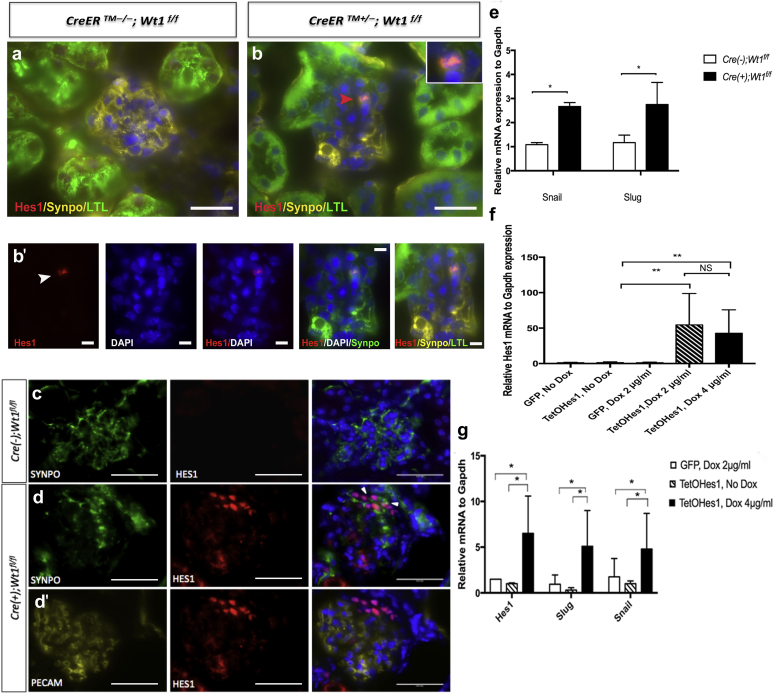
Hairy enhancer of split 1 (HES1) expression coincides with onset of glomerulosclerosis in CAGG-CreERTM+/−;Wt1f/ftransgenic mice. (a,b,b′) Shown are representative images of glomeruli following double immunofluorescence labeling of day (D) 5 postinduction (PI) mouse kidney sections with anti-HES1, anti-Synaptopodin, and Lotus tetragonolobus lectin (LTL) of CAGG-CreERTM−/−;Wt1f/f (mutant) and CAGG-CreERTM+/−;Wt1f/f (control) transgenic mice following multichannel labeling with Alexa Fluor 488–conjugated secondary antibody (LTL, demarcates tubules), Alexa Fluor 594–conjugated secondary antibody (Hes1), and Alexa Fluor 647–conjugated secondary (Synaptopodin, demarcates podocytes). Sections are counterstained with 4′,6-diamidino-2-phenylindole (DAPI). Bars = 50 μm. (b,b′) In mutants, HES1-positive, Synaptopodin-positive glomerular epithelial cells were observed in regions distinct from LTL-positive tubules. Bars = 50 μm. (b′) Bars = 10 μm. (c,d,d′) Segmental clusters of nuclear HES1 expression in Synaptopodin-positive, platelet–endothelial cell adhesion molecule (PECAM)-negative podocytes are evident in mutant glomeruli and not evident in control glomeruli. Bars = 50 μm. (e) Upregulation of podocyte Snail and Slug transcript at onset of glomerulosclerosis at D6 PI. Median Snail mRNA expression at D6 PI in control versus mutant mice: 1.1 (interquartile range [IQR]: 0.9, 1.2) versus 2.7 (IQR:1.8, 2.8), *P = 0.045, Mann-Whitney test. Median Slug mRNA expression at D6 PI in control versus mutant mice: 1.2 (IQR: 0.6, 1.5) versus 2.8 (IQR: 1.4, 3.7), *P = 0.03, Mann-Whitney test. (f) Increase in Hes1 mRNA in doxycycline-treated primary Nphs2;rtTA podocytes transduced with TetOHes1 plasmid compared with untreated TetOHes1 and treated green fluorescence protein (GFP)–transduced primary Nphs2;rtTA podocytes. Mean Hes1 mRNA expression relative to Gapdh (±SD): untreated control (GFP) versus untreated TetOHes1 versus treated control (doxycycline 2 μg/ml) versus treated TetOHes1 (2 μg/ml) versus treated TetOHes1 (4 μg/ml): 1.15 ± 0.66 versus 1.26 ± 1.13 versus 1.21 ± 0.88 versus 54.56 ± 44.24 (**P < 0.004) versus 42.78 ± 33.07 (**P < 0.008). No significant difference in dose observed, P = .045 (not significant [NS]). (g) Upregulation of Snail and Slug transcripts, genes implicated in epithelial to mesenchyme transition in doxycycline-treated primary Nphs2;rtTA podocytes transduced with TetOHes1 plasmid compared with untreated TetOHes1 and treated GFP-transduced primary Nphs2;rtTA podocytes. Untreated control (GFP) versus untreated TetOHes1 versus treated TetOHes1 (4 μg/ml): mean Snail mRNA expression relative to Gapdh (±SD): 1.76 ± 2.1 versus 1.01 ± 0.31 versus 4.82 ± 3.94, *P < 0.05. Mean Slug mRNA expression relative to Gapdh (±SD): 0.95 ± 1.12 versus 0.31 ± 0.26 versus 5.10 ± 0.3.9 (*P < 0.05). To optimize viewing of this image, please see the online version of this article at www.kidney-international.org.